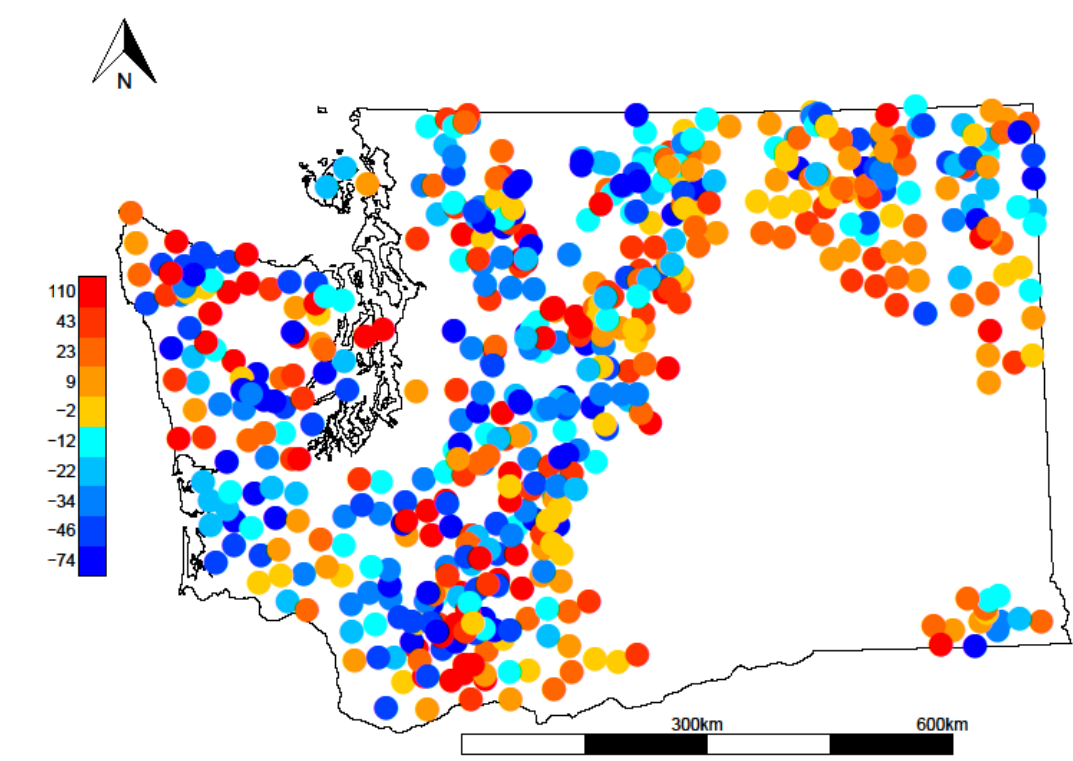
Figure 7. Volume (VPHC_GE_3) residual pattern (m 3 /ha in percent of the mean) for OLS model fit with best performing set of height, environment, and Landsat predictors ( p -value < 0.0001 for Moran’s I test).